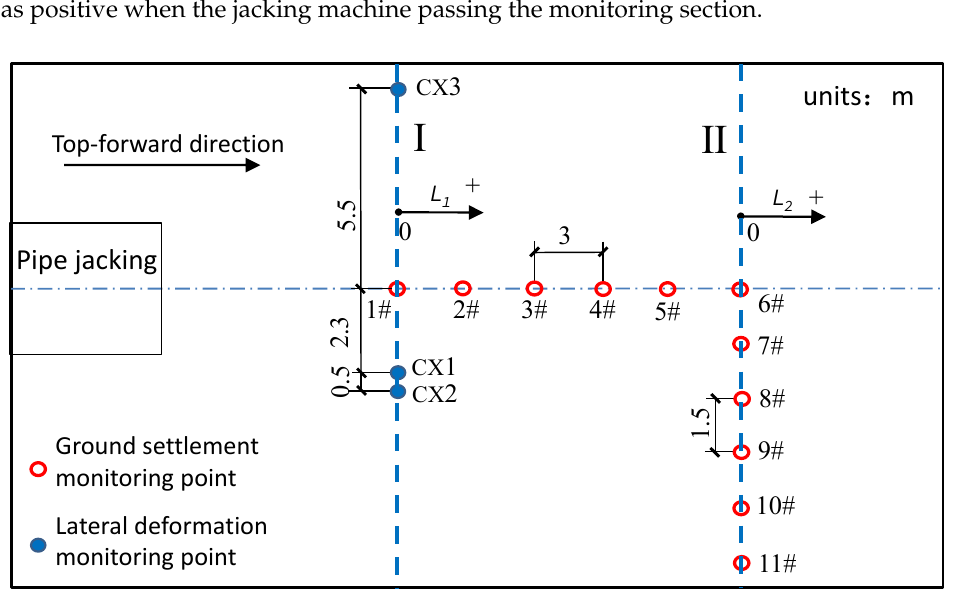
Figure 2. Layout plan of on-site monitoring points.